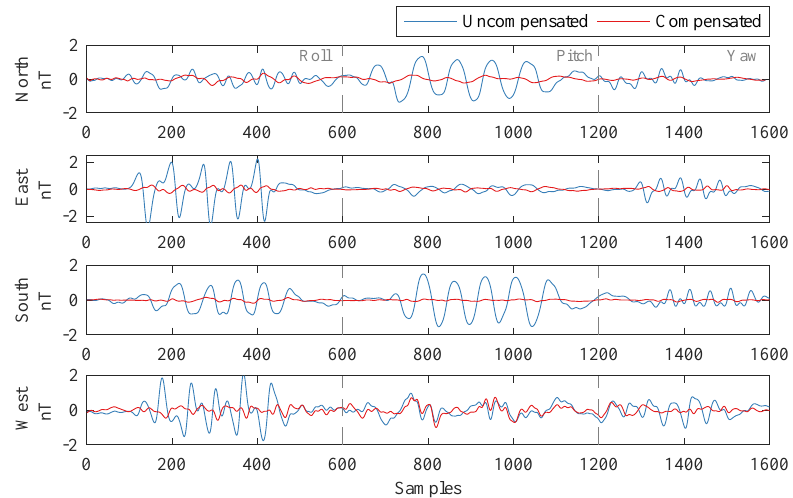
Figure 4. Compensation